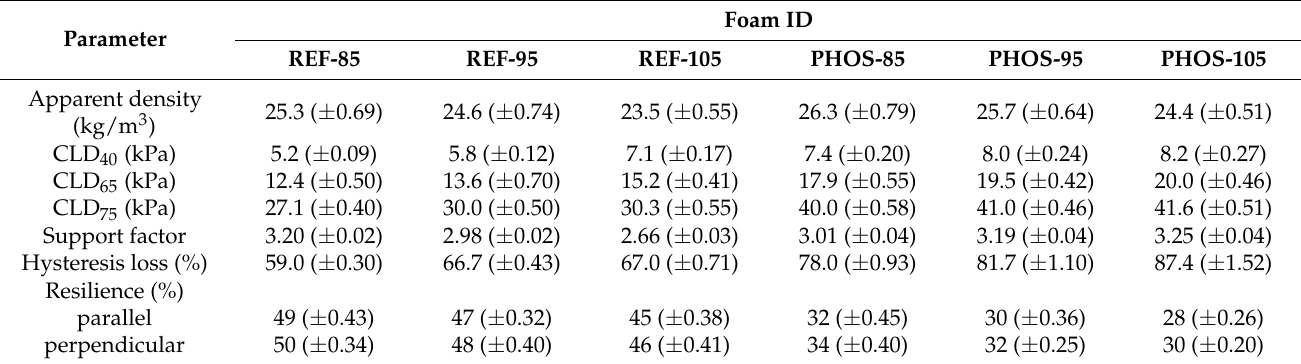
Table 4. Apparent density and mechanical properties of flexible